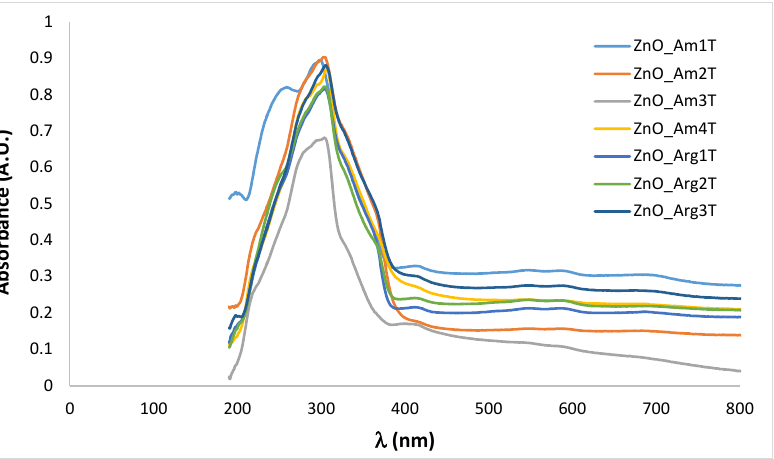
Figure 8. UV-Vis spectra of ZnO NPs prepared in situ on cotton under microwave irradiation under various conditions * ) on textile support. (*) Sample codification corresponding to the reaction conditions that are detailed in Table 1.